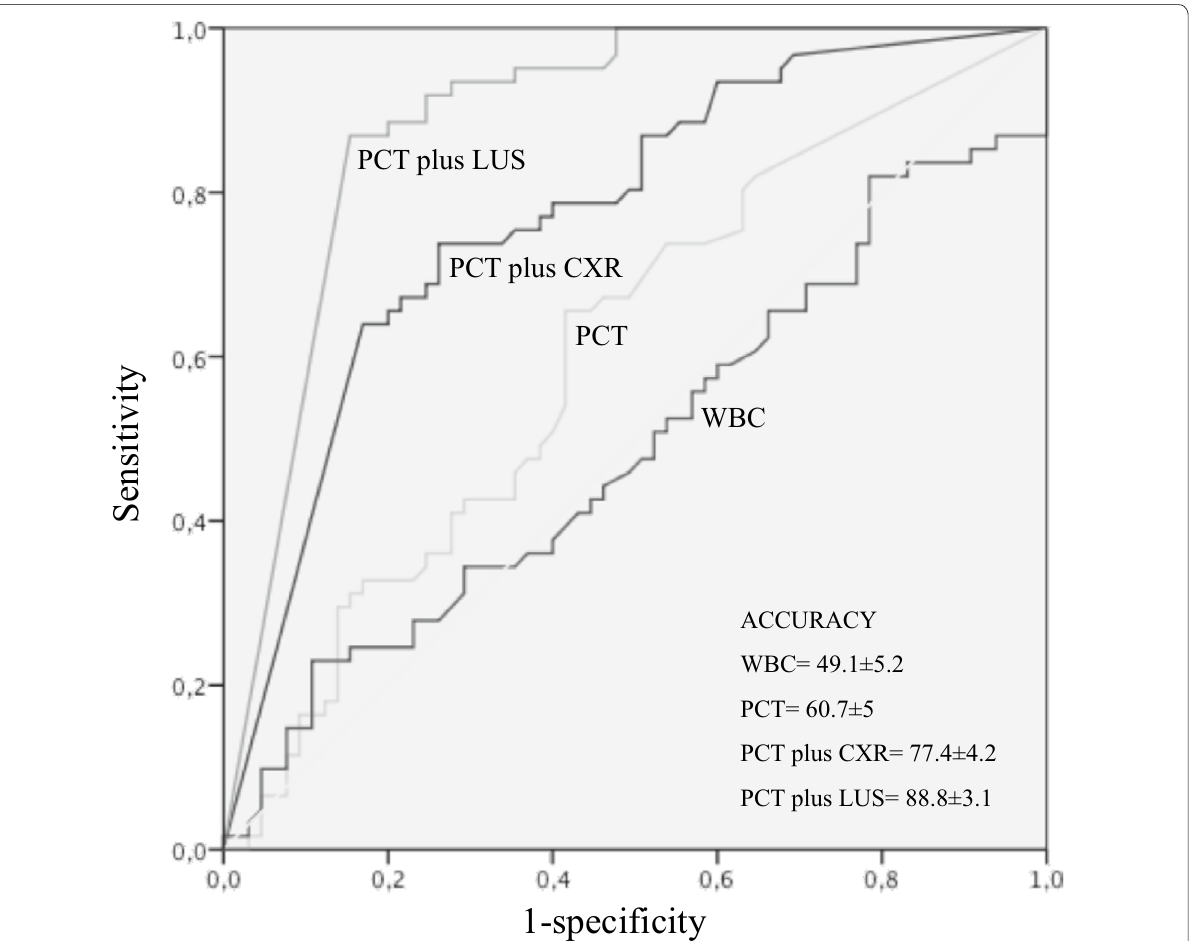
Fig. 2 ROC curve of WBC, PCT, LUS and CXR and their combination. WBC white blood cells; PCT procalcitonin; LUS lung ultrasonography; CXR chest